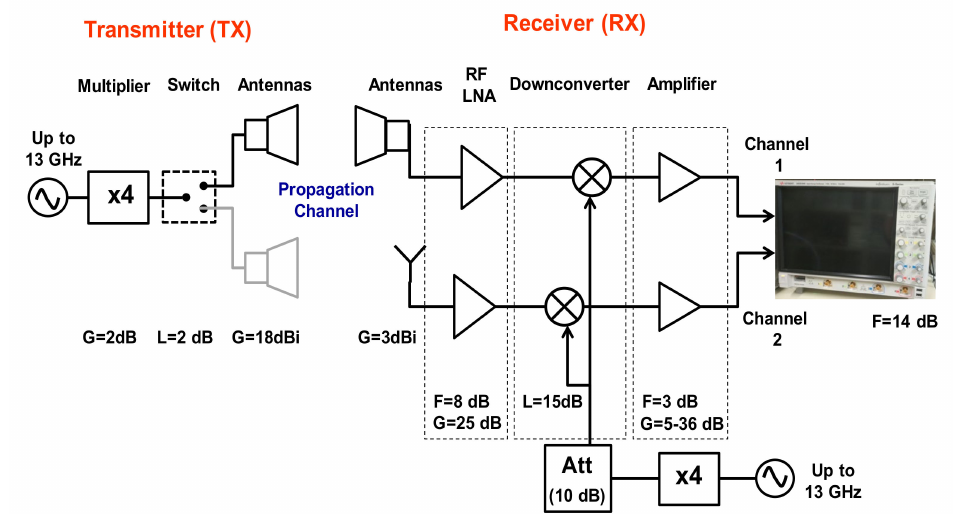
Figure 1. Transmitter and receiver scheme (main characteristics of each device are shown below them, with G, L, F, Att, and LNA standing for gain, losses, noise figure, attenuation, and low noise amplifier,